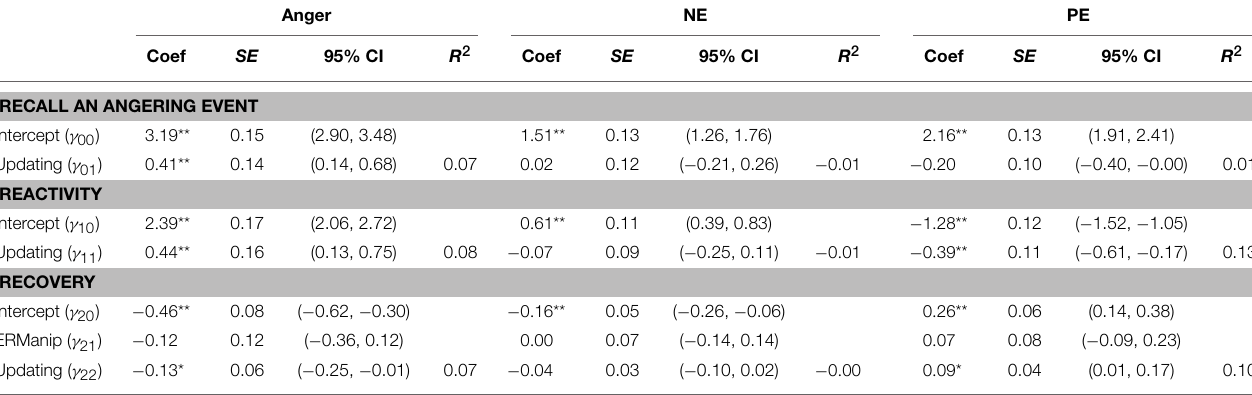
TABLE 4 | Moderating effect of updating on emotion reactivity to and emotion recovery from recalling a personal angering event in Study 2.